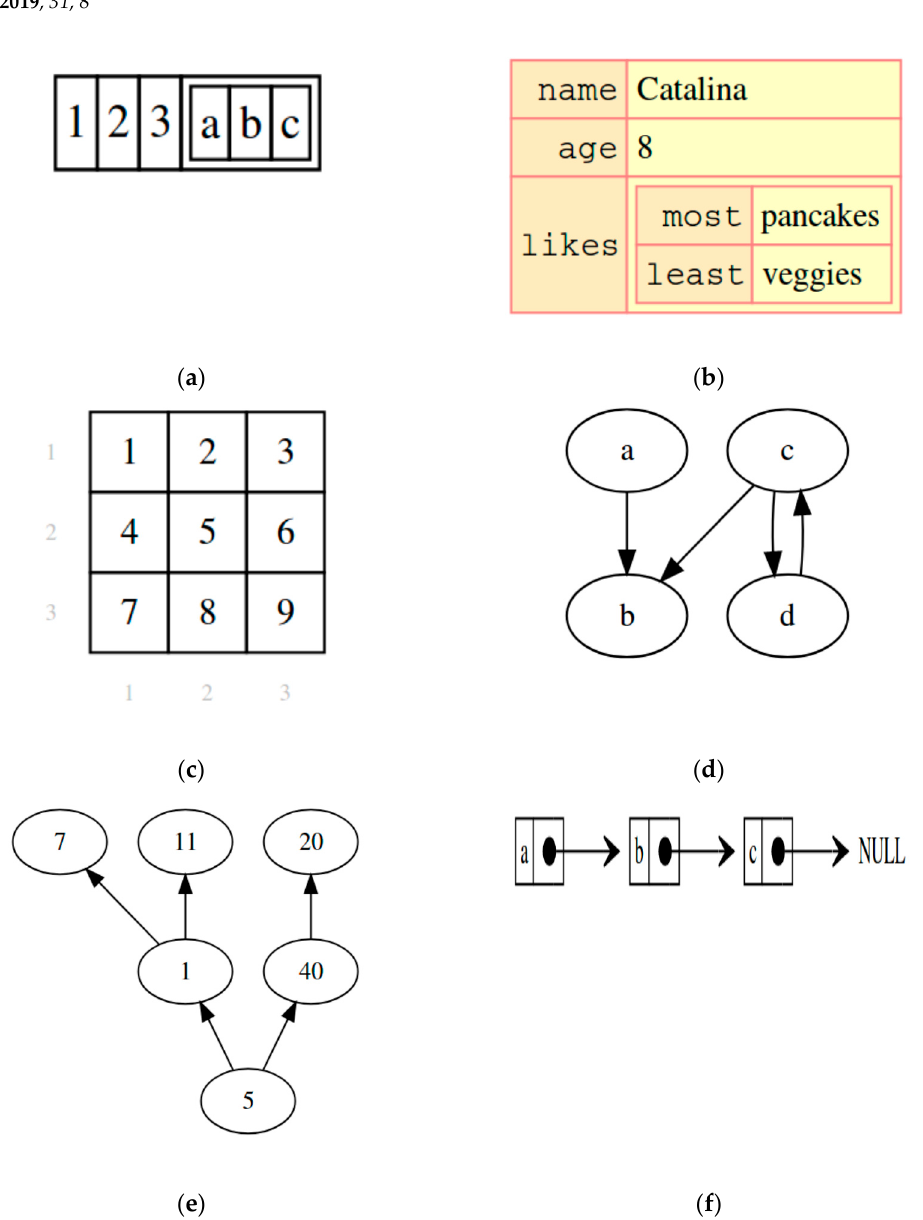
Figure 1. ( a ) An array. ( b ) a table. ( c ) a nested matrix. ( d ) a graph. ( e ) an inverted tree. ( f ) a linked